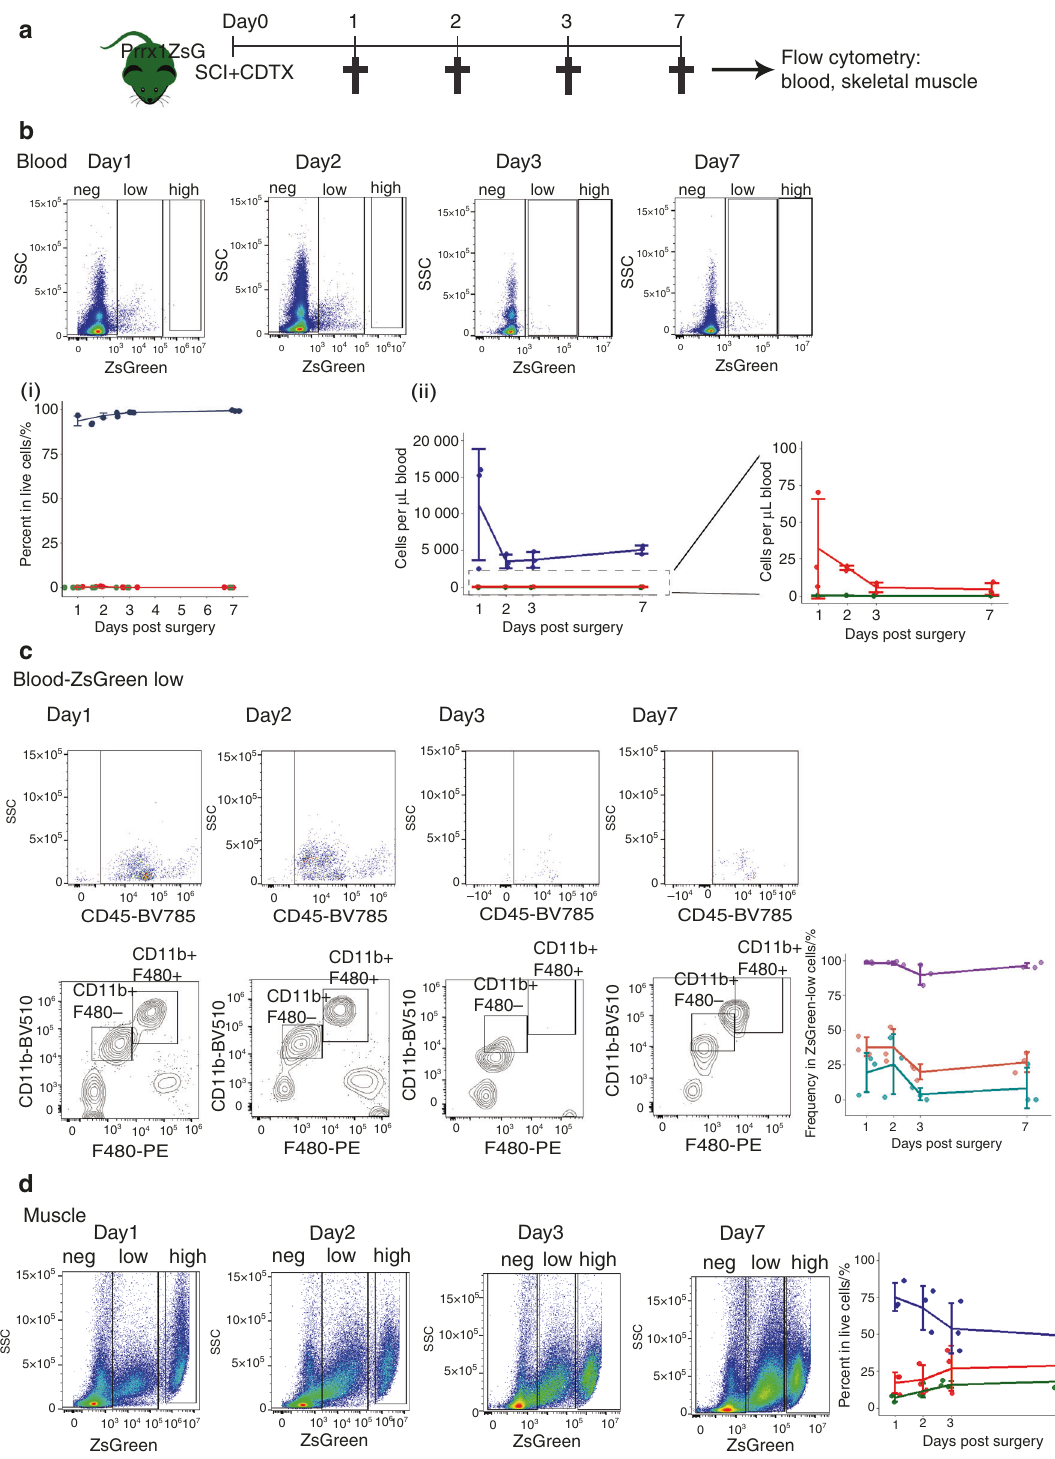
Fig. 4 Absence of ZsGreen high mesenchymal cells in the circulation of the Prrx1 ZsG mice after SCI and muscle injury. a Prrx 1 ZsG mice received SCI and an intramuscular injection of CDTX. Peripheral blood and skeletal muscles were collected at 1, 2, 3, and 7 days post-surgery and analyzed by fl ow cytometry ( n = 3 mice/group). b FVS700 − live cells from peripheral blood were gated based on the intensity of ZsGreen fl uorescence into ZsGreen negative (blue lines), low (red lines) and high groups (green lines). The frequency of these three populations is represented as ( i ) the frequency of live cells in blood and ( ii ) the number of cells per μ l blood. c The ZsGreen-low cells were further gated for expression of CD45, CD11b and F480. The frequency of CD45 + leukocytes (purple line), CD45 + CD11b + F4/80 + monocytes (red line) and CD45 + CD11b + F4/80 − granulocytes (blue line) among circulating ZsG low cells was plotted. d Live cells from injured muscle from the same Prrx1 ZsG mice were used as a reference for ZsGreen fl uorescence intensity, con fi rming the presence of numerous ZsGreen high cells in muscle. ZsGreen negative (blue lines), low (red lines) and high (green lines). Each dot represents a separate mouse. Bars represent the mean ± SD. There was no signi fi cant difference between the time points as determined by one-way ANOVA with Tukey ’ s multiple comparison